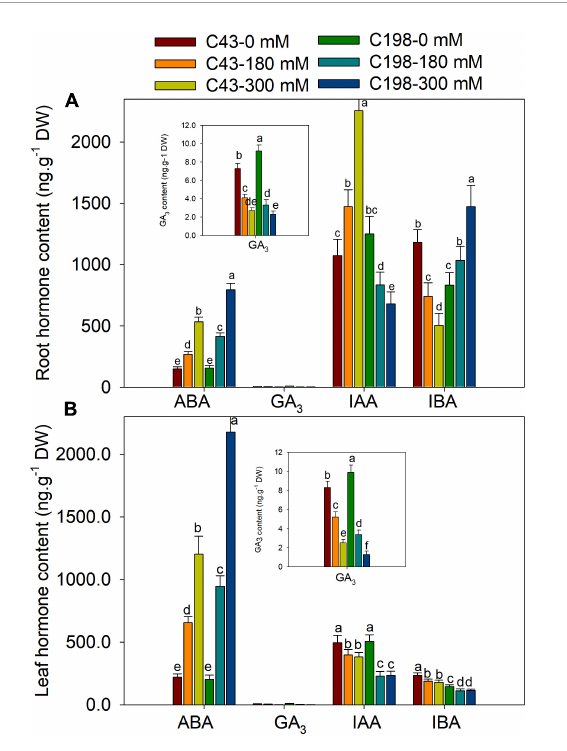
FIGURE6 Effects of salt stress on root (A) and leaf (B) cytokinin content in the two genotypes of bermudagrass (C43, tolerant; C198, sensitive). Bars marked by the same letters are not significant at P < 0.05 (Tukey’s test) for the comparison of different salt concentrations in two genotypes. Data represent the mean ± SD of four independent biological replicates.